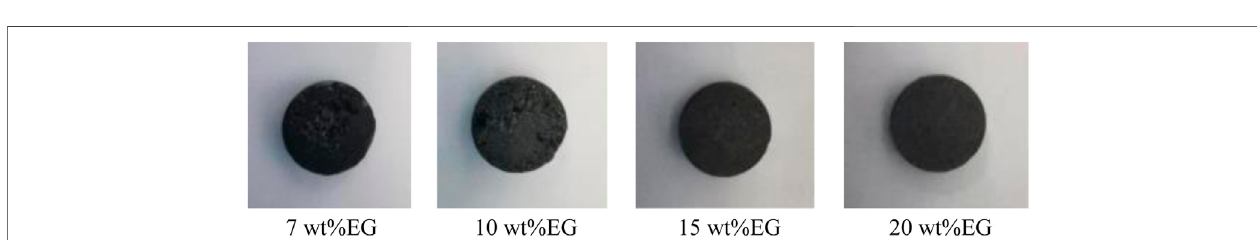
FIGURE 3 | Morphology of composites with different EG content after sintering.